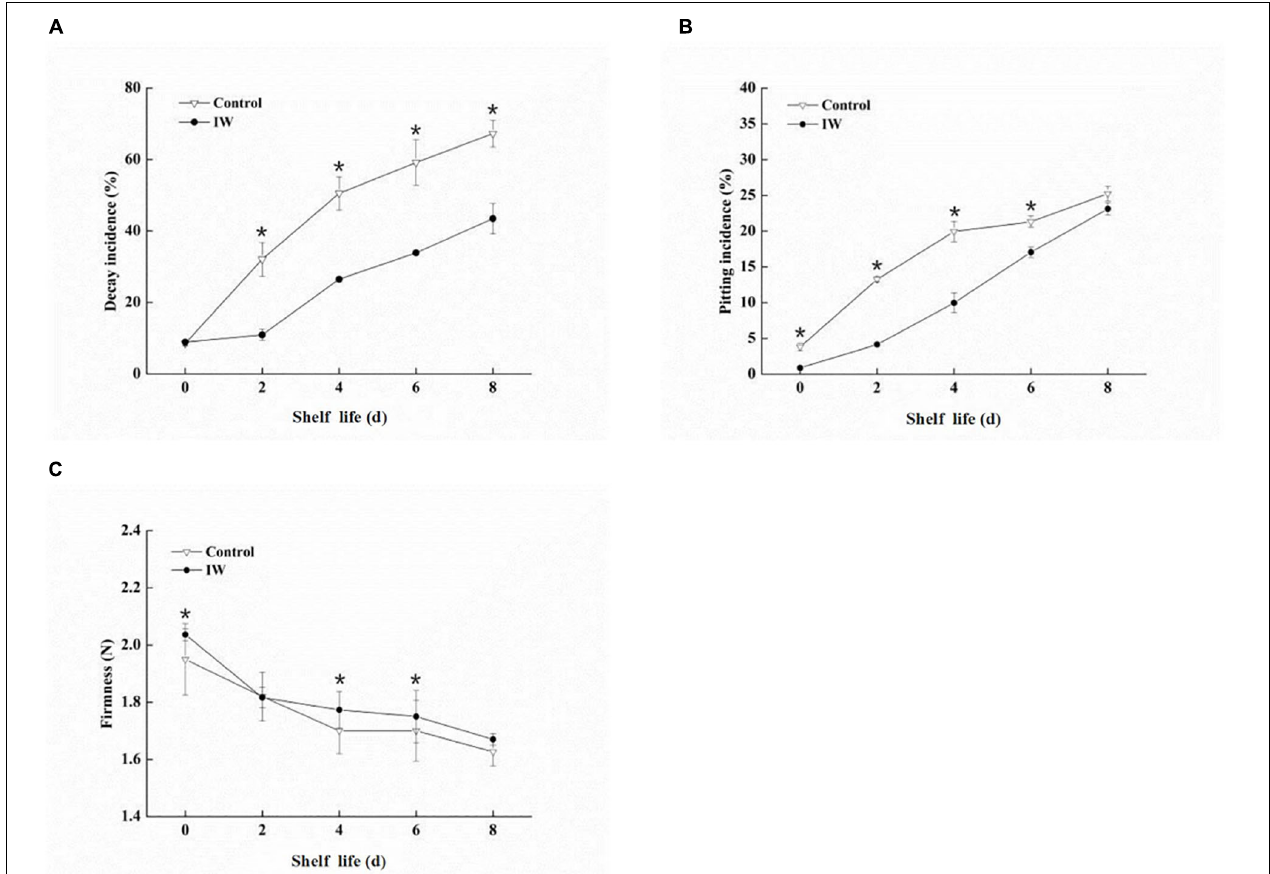
FIGURE 1 | Effect of intermittent warming on decay incidence (A) , pitting incidence (B) , and firmness (C) of blueberry fruit during shelf life at room temperature after a 30-day refrigeration. Mean ± SE of three replicate experiments are shown. Asterisks indicate significant differences between control and IW-treated fruit (* p < 0.05).